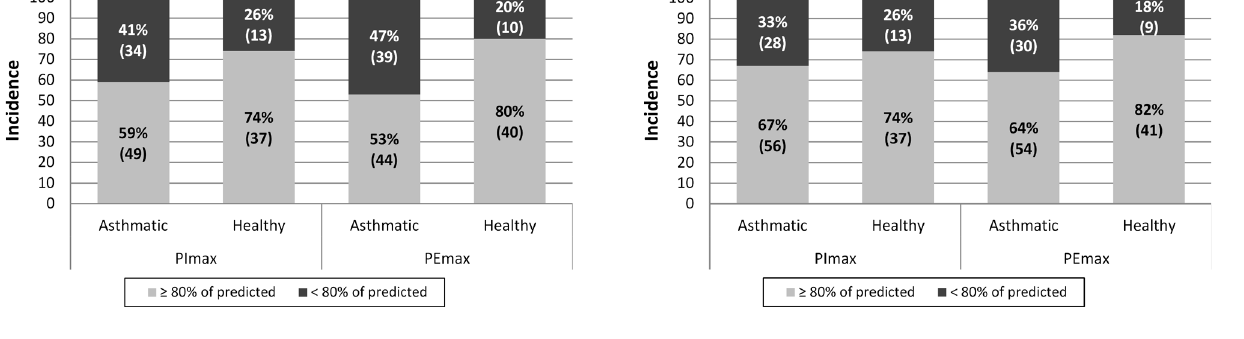
) max ) mouth pressures in max